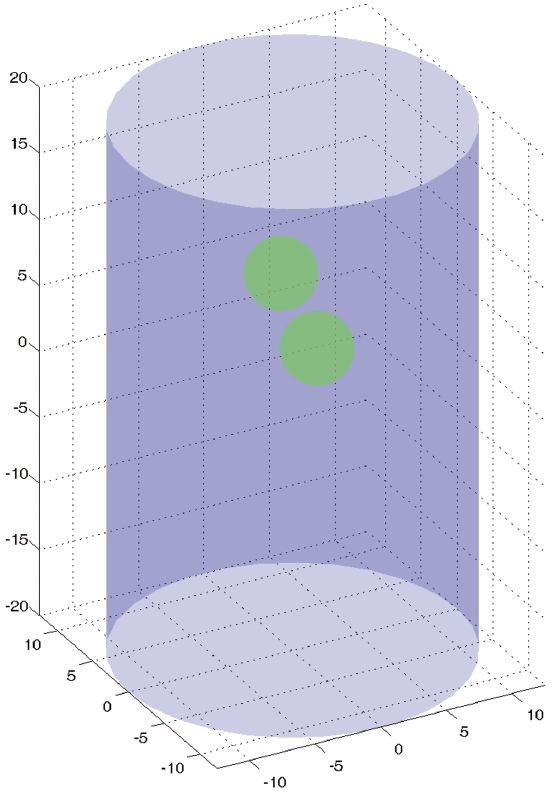
Fig. 3. The simulation mode.